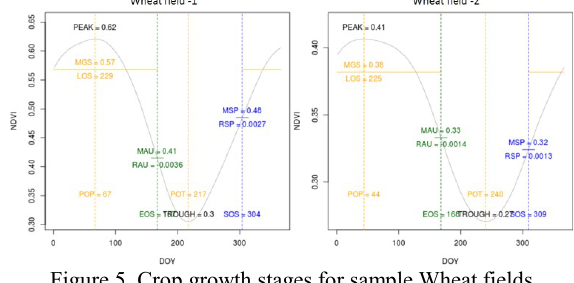
The results of Wheat crop growth stage detection algorithm estimates day of year (DOY) for Start of Season (SOS), End of Season (EOS), Length of Season (LOS), Position of Trough (POT), Mean Spring value (MSP) and Rate of Spring Greenup crop canopy are captured in Figure 5. The cropping season